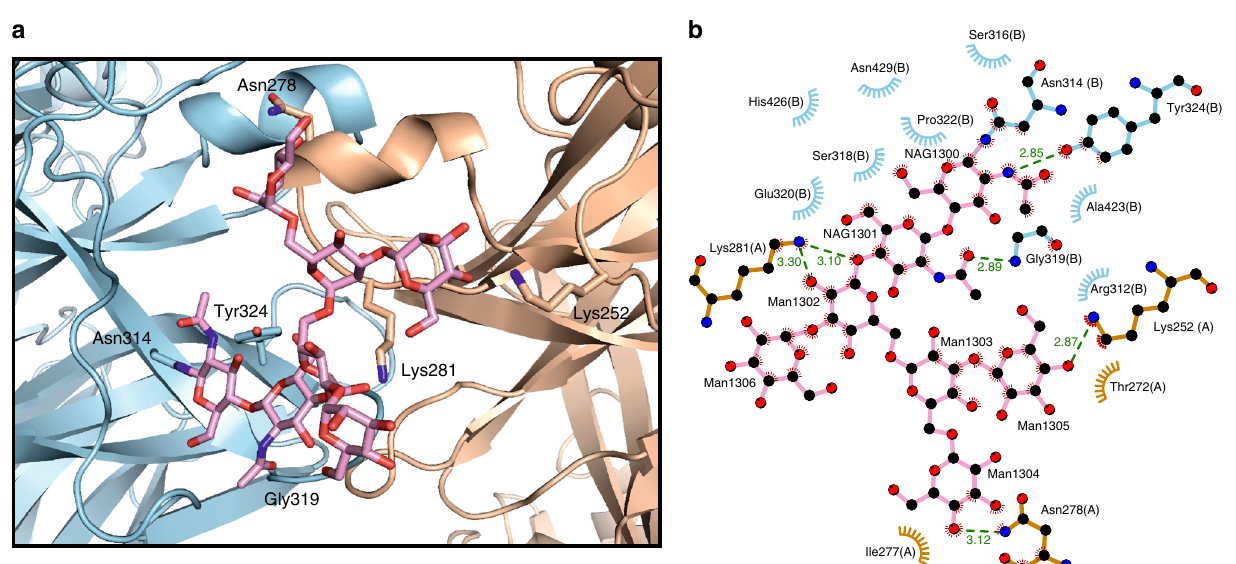
Fig. 4 N-linked glycans are involved in the semaphorin homodimerization. a Close-up view of the N-linked glycans at residue N314 in the Sema2a 1 – 3 crystal structure. The N-linked glycans of chain B (blue) form intermolecular interactions with residues of chain A (orange). b Schematic representation of the interactions between the glycans at N314 and residues from chain A (blue) and chain B (orange) adapted from Ligplot 65